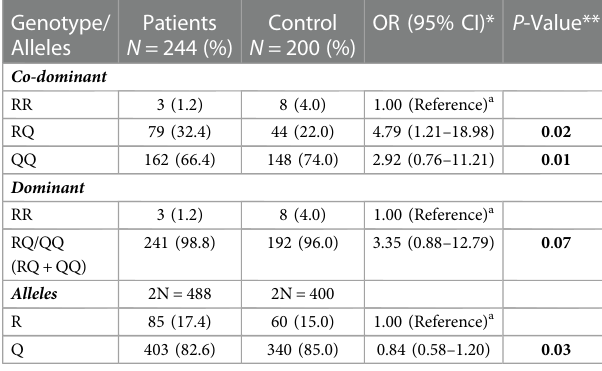
DQ2/DQ8 genotype, 39/56 (70%) had the homozygous CC genotype and 87% co-inherited at least one variant “ C ” allele of the IL4 gene polymorphism along with the high-risk HLA-DQ2/ DQ8 genotype ( Figure 3 ).